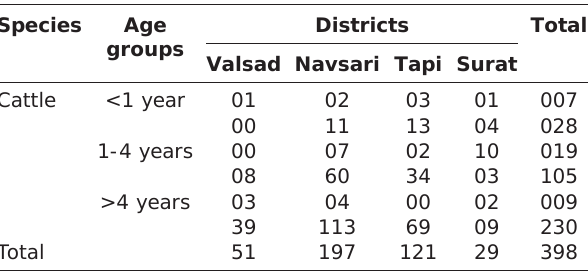
Table-1: Details of age-wise sample collection in cattle. Species